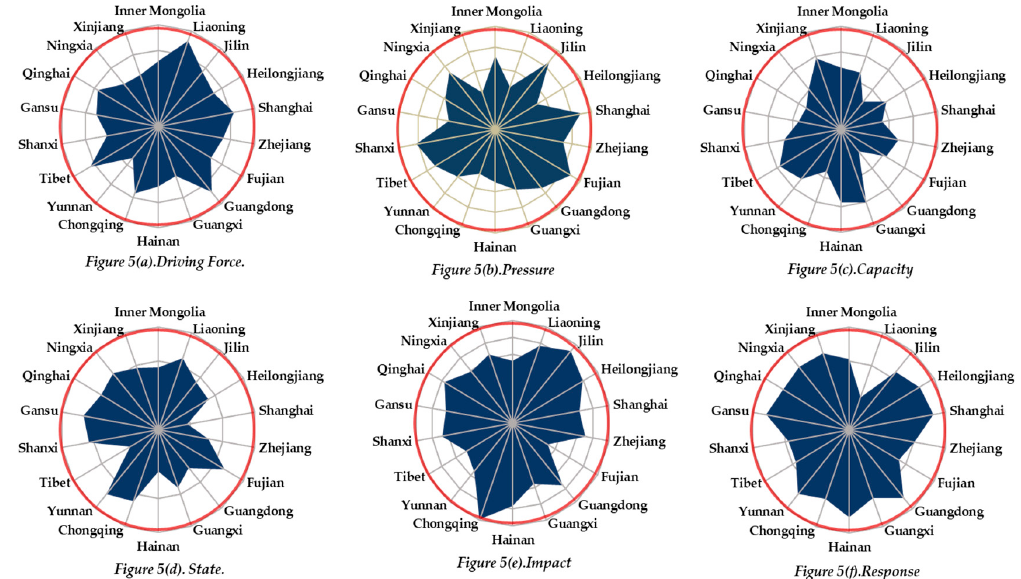
Figure 4. The influence coefficient of the DPCSIR framework on water security in the One Belt And One Road Region of China from 2011 to 2016.